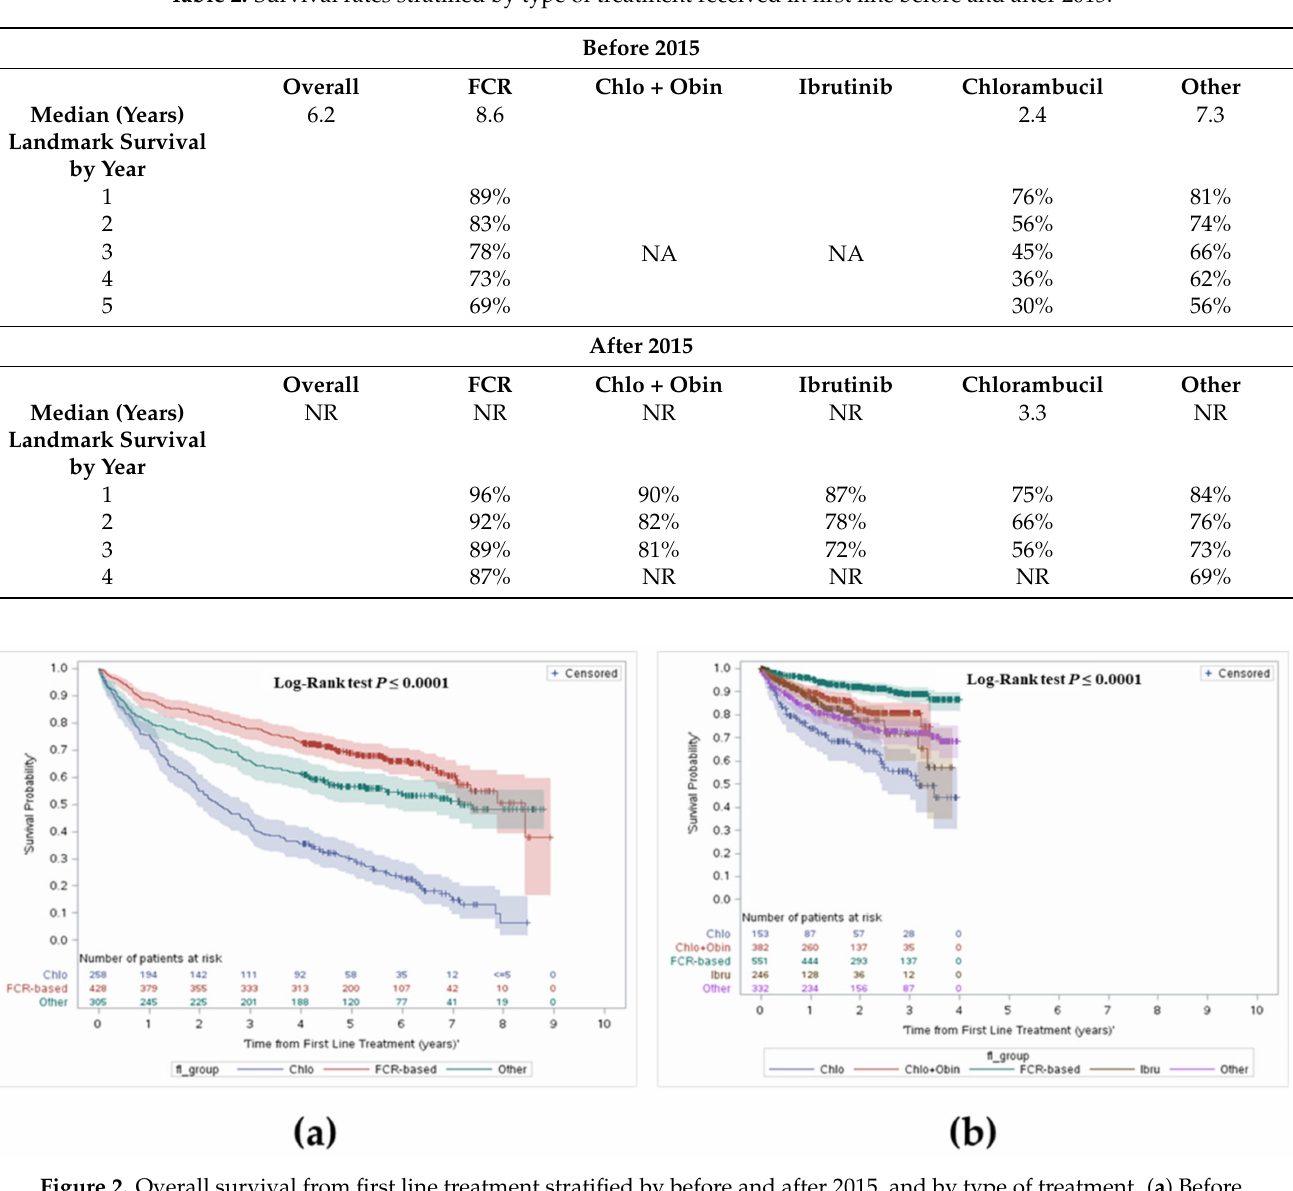
Figure 2. Overall survival from first line treatment stratified by before and after 2015, and by type of treatment. ( a ) Before 2015; ( b ) After